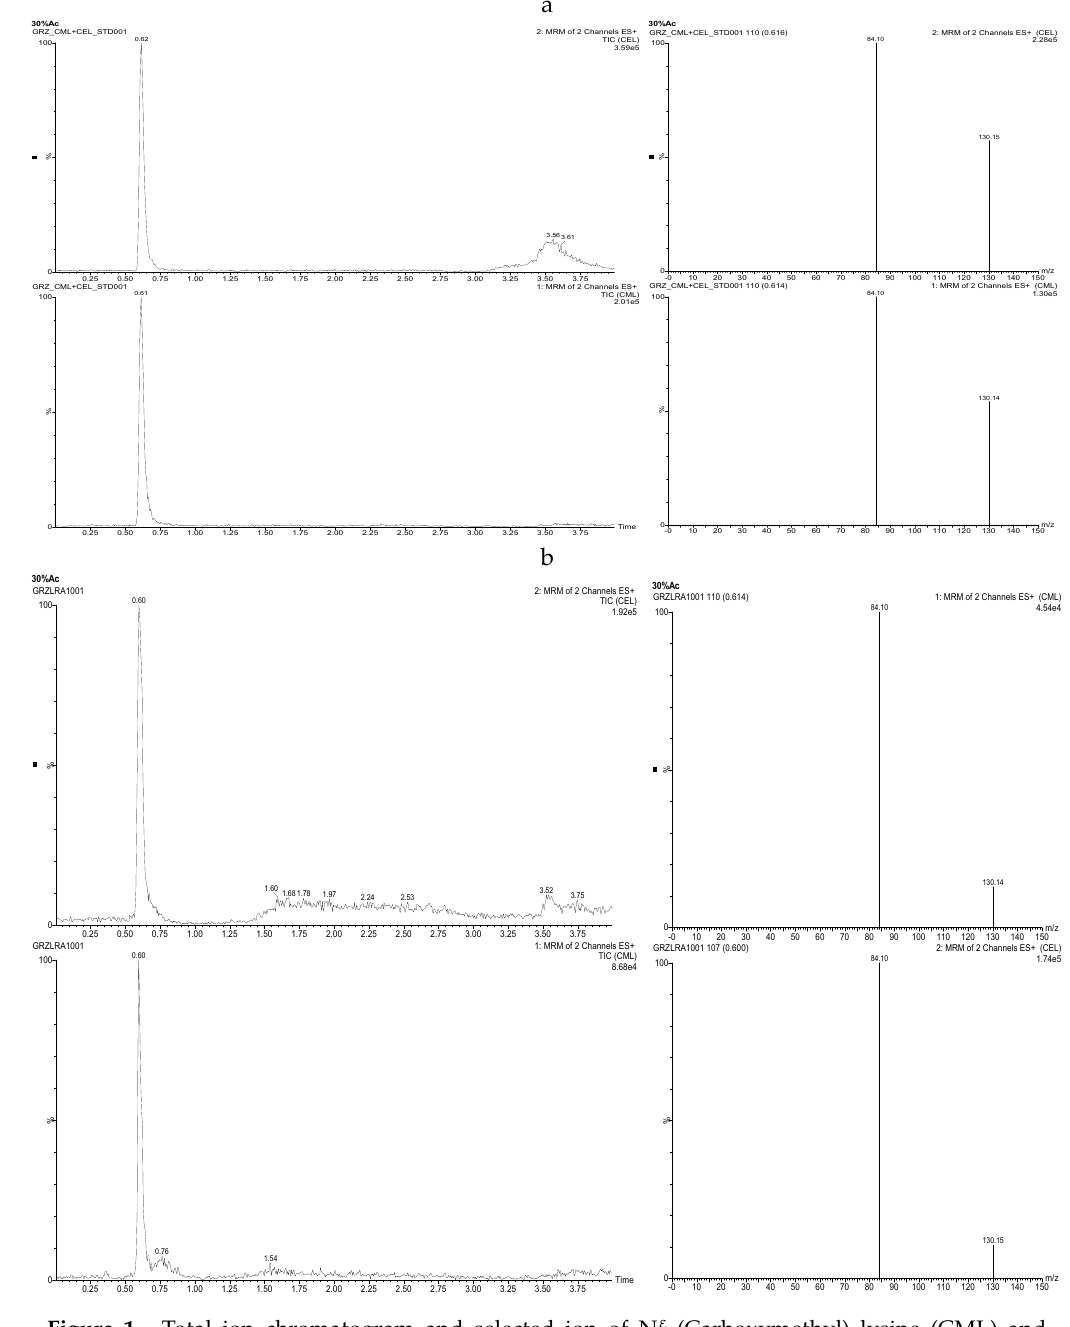
Figure 1. Total ion chromatogram and selected ion of N ε -(Carboxymethyl) lysine (CML) and N ε -(carboxyethyl) lysine (CEL) standard solutions ( a ) and antler velvet samples ( b